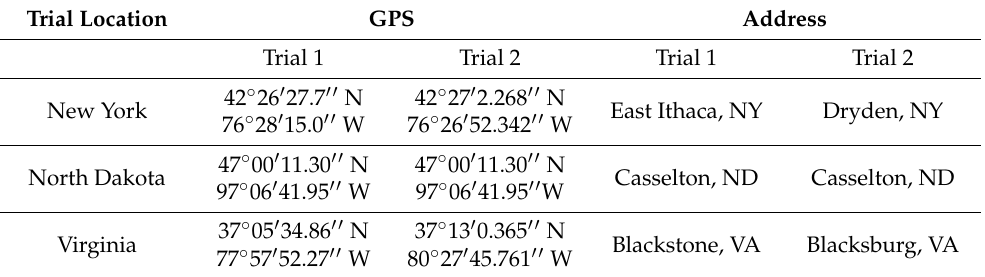
Table 3. Trial GPS locations, and